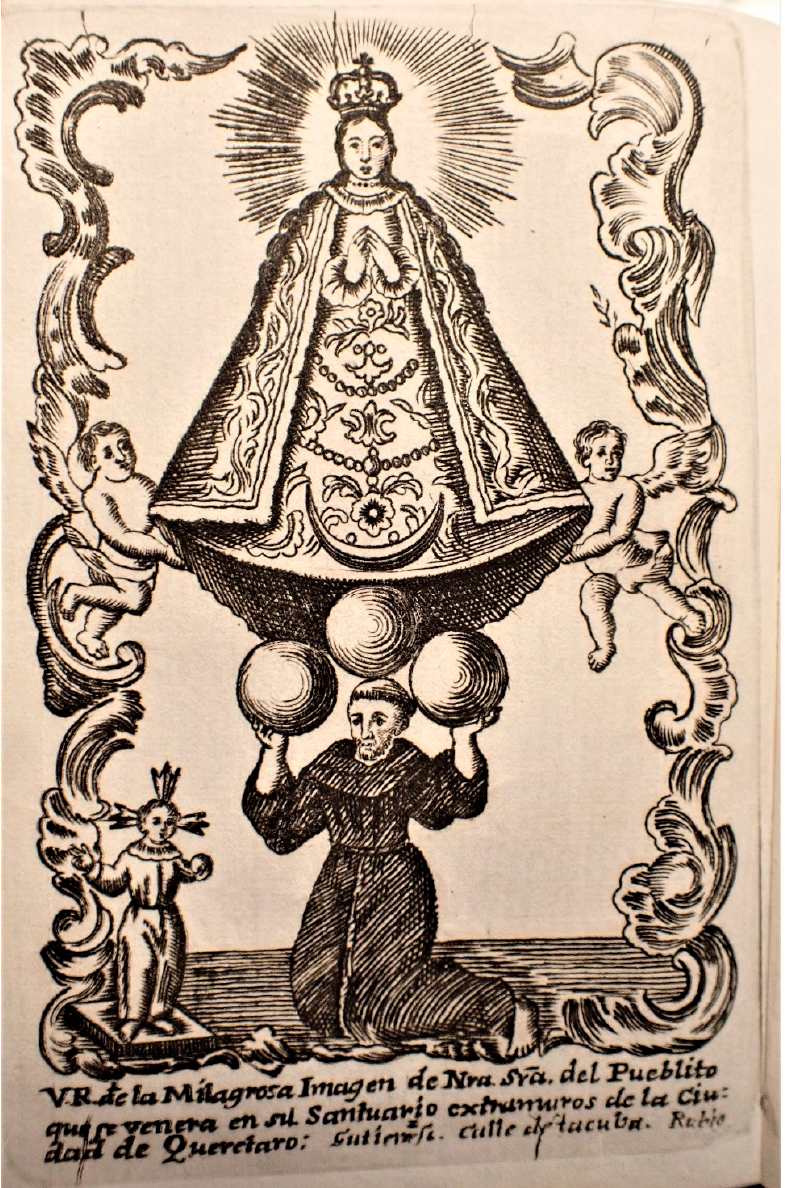
Figure 4. Francisco Gutiérrez and Augustín Rubio, Nuestra Señora del Pueblito , ca. 1770. Engraving. Photography by the author.